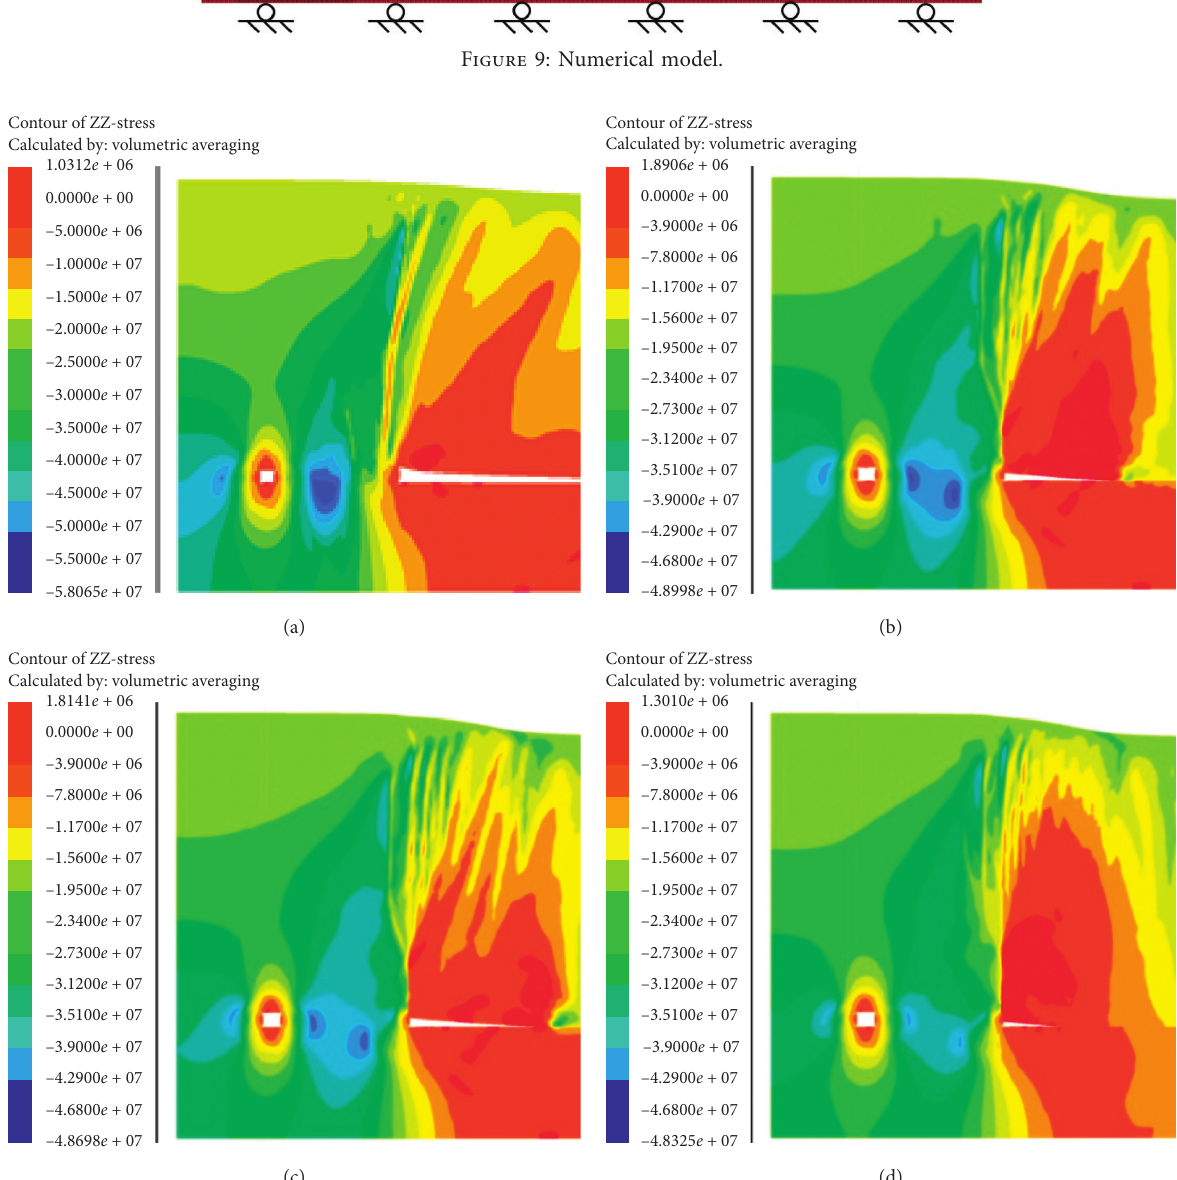
Figure 10: Z -directional stress: (a) cutting height 0m; (b) cutting height 10 m; (c) cutting height 12 m; and (d) cutting height